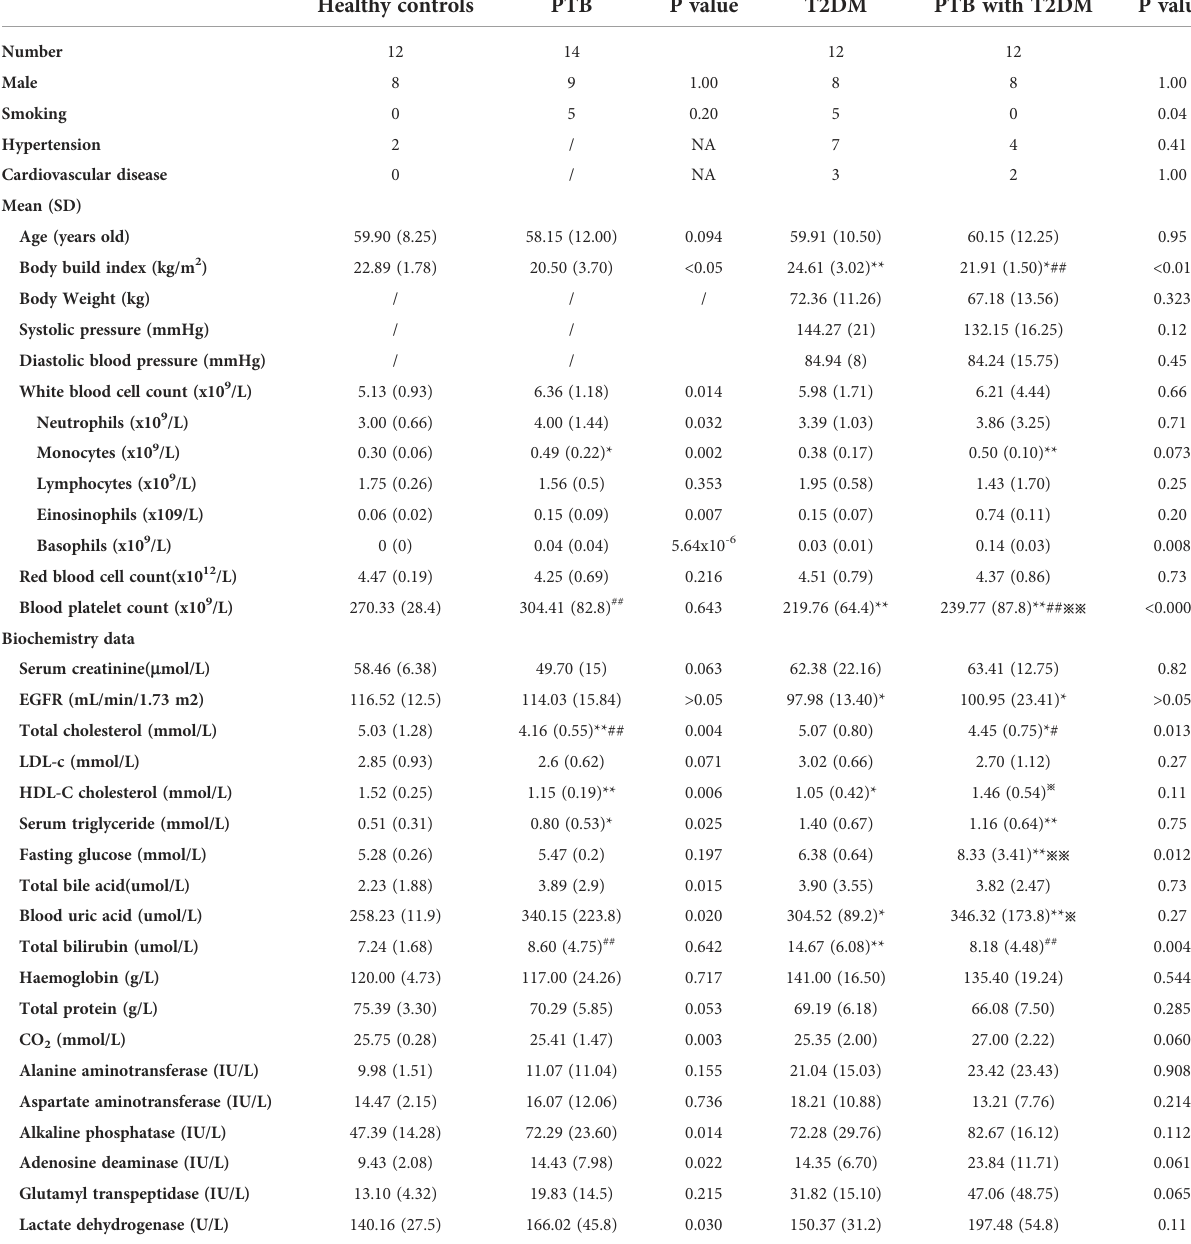
TABLE 1 General characteristics of the study